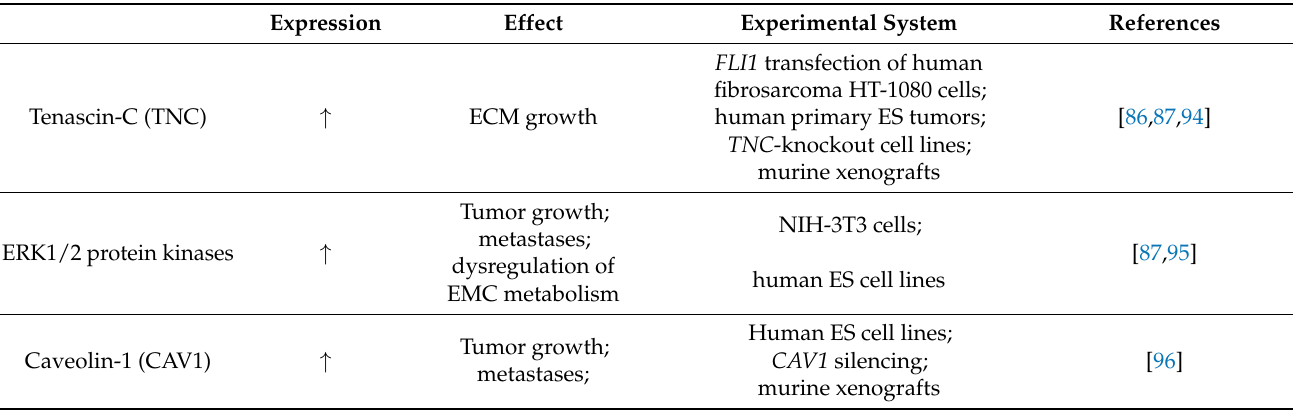
Table 2. Fli1-associated oncogenic